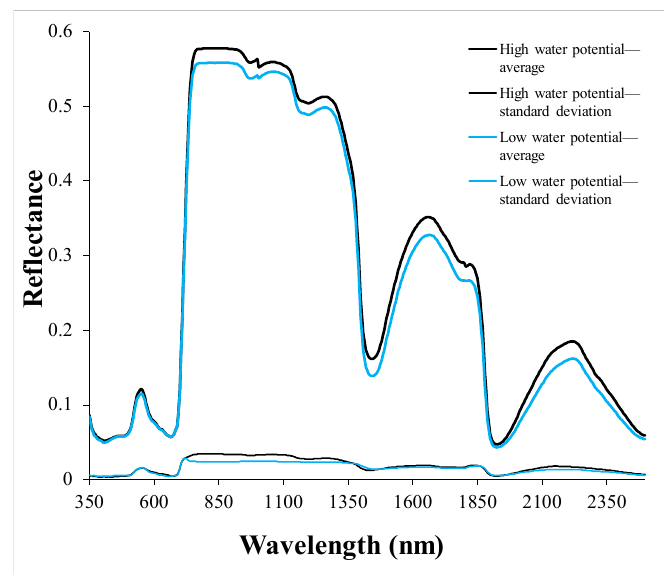
Figure 3. Spectral signatures of leaves with high water potential (black line) and low water content (blue line). The spectral signatures were drawn from seven samples each for the highest and the lowest water potential.